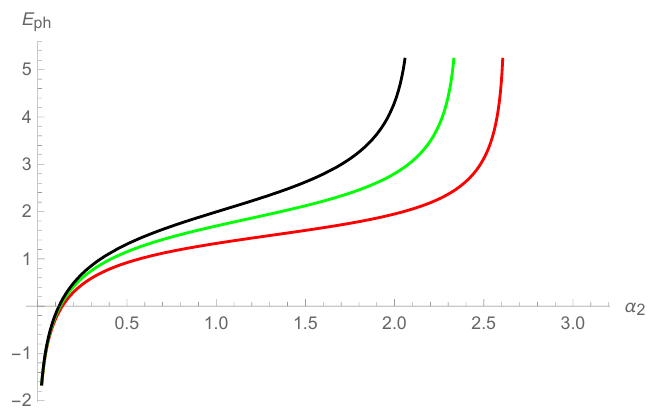
Figure 4. Plot of E ph for 2 adjacent intervals as a function of (cid:11) 2 , at (cid:12)xed (cid:11) 1 . The values of (cid:11) 1 are: (cid:25)= 6 (red), (cid:25)= 4 (green) and (cid:25)= 3 (black). We set the cuto(cid:11) (cid:15) to 0 : 1 and 4 G N =